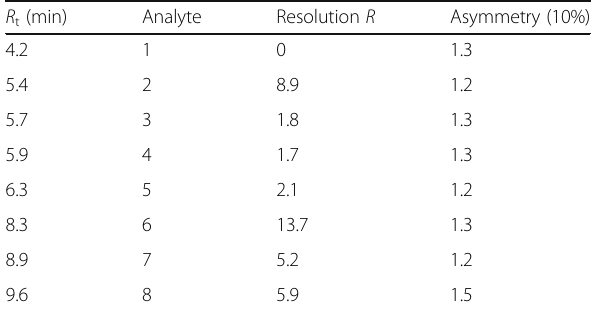
Table 1 Retention times and chromatographic values of each analyte obtained by the HPLC method R t (min) Analyte Resolution